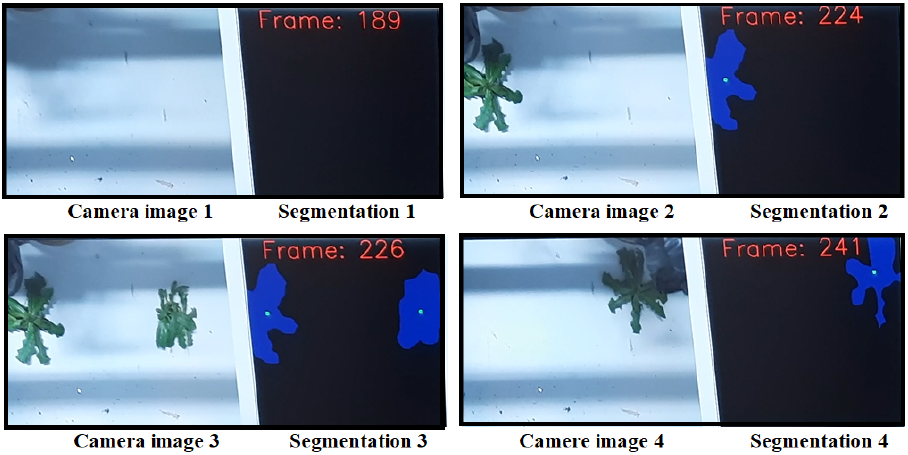
Figure 14. Real-time application result: segmentation of weeds. Details of an image sequence.